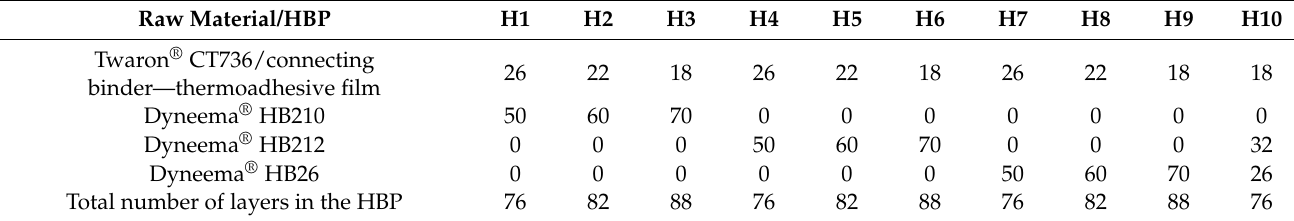
Total number of layers in the HBP